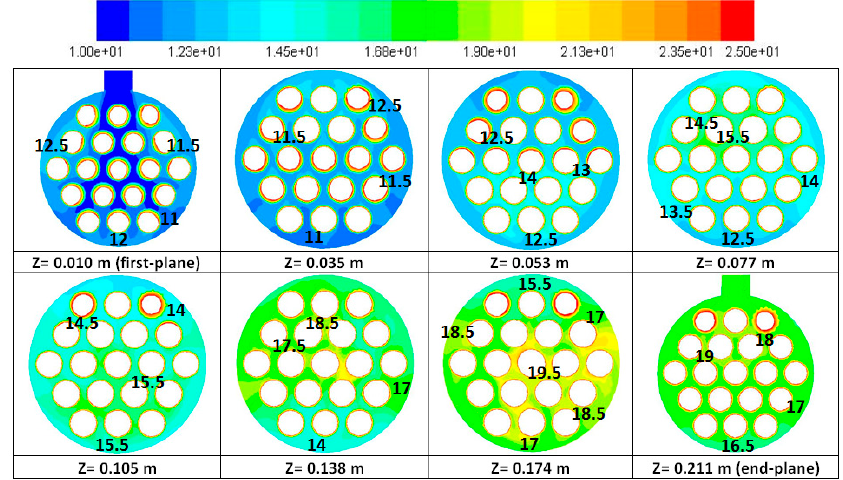
Figure 12. Prediction of temperature ( ◦ C) distribution at section planes defined in shell side (Case-III).